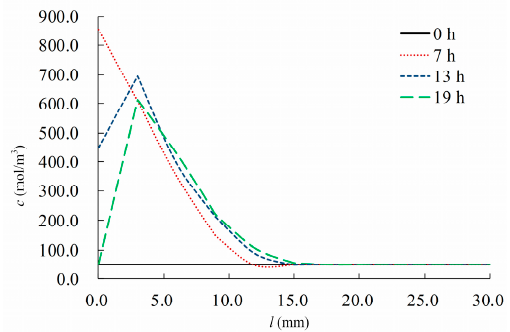
Figure 9. The change curves of chloride ion concentration, c , with depth, l.